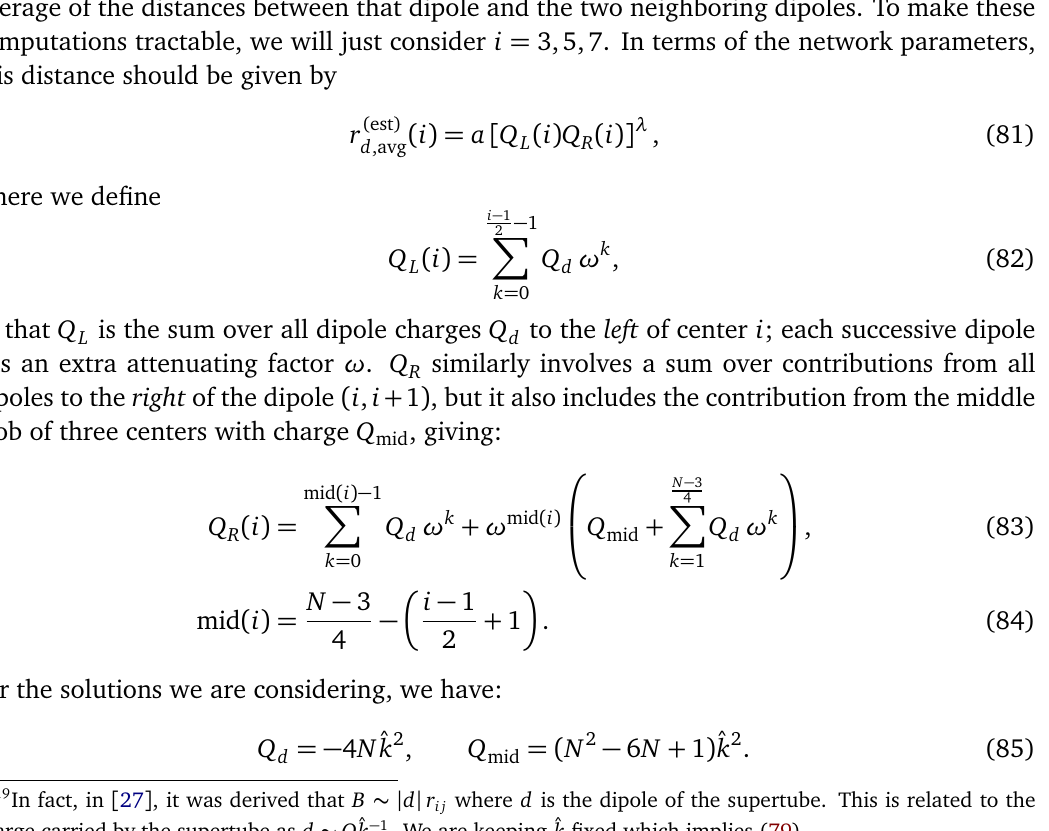
Figure 22: The black hole microstate of N centers on a line with v = − v k I N ˆ k + ˆ k ; positive and negative values of v are drawn in blue and red, re- i i spectively. The centers organize themselves into dipoles, except the “middle blob”